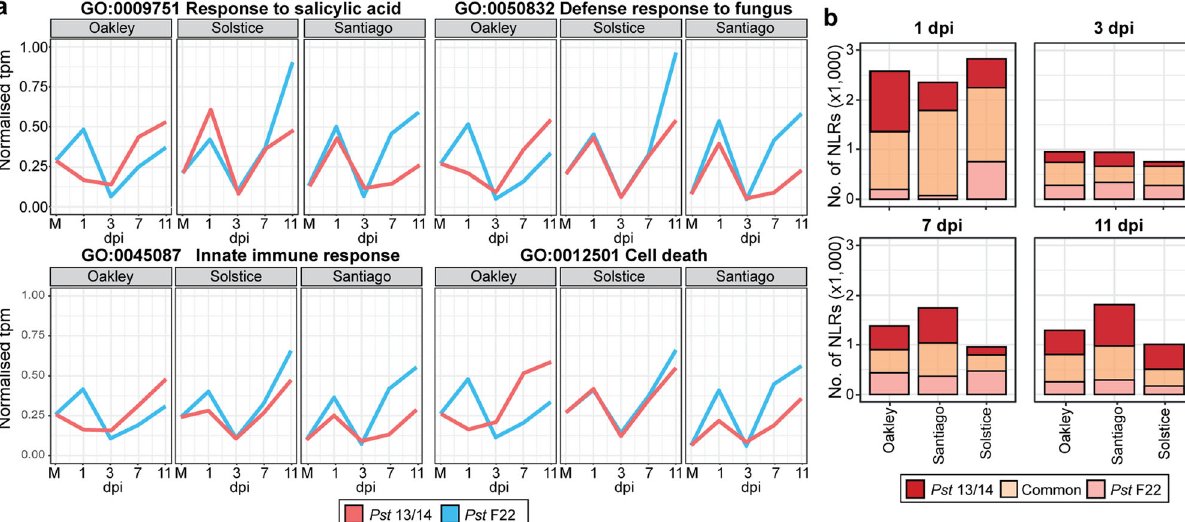
Fig. 4 Genes involved in host defence-related responses show different expression patterns across different Pst – variety pairs and re fl ect host susceptibility. a Median expression of normalised transcripts per million (tpm) values obtained for genes annotated as being involved in response to salicylic acid (GO:0009751), defence response to fungus (GO:0050832), innate immune response (GO:0045087) and cell death (GO:0012501). The peak in gene expression at later stages of infection (7 – 11 dpi) is more pronounced in resistant interactions ( Pst isolate F22 – Santiago) when compared to its susceptible counterpart ( Pst isolate 13/14 – Santiago). b The number of DEGs encoding proteins with typical NLR domains is greatest at 1 dpi, with the most DEGs at this time point identi fi ed in samples from Oakley infected with Pst 13/14 (most susceptible interaction). Typical NLR domains were de fi ned as IPR001611:Leu-rich_rpt, IPR032675:LRR_dom_sf, IPR002182:NB-ARC, IPR027417:P-loop_NTPase. Genes were considered differentially expressed compared to the control when q -value <